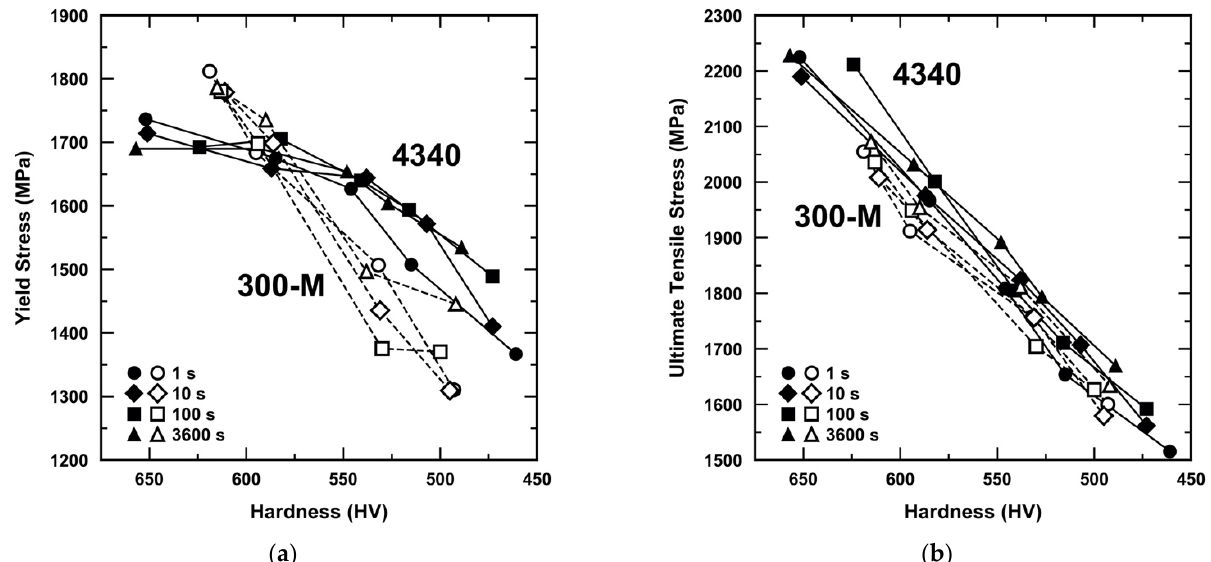
Figure 1. Comparison of (a) yield strength (0.2 pct offset) and (b) ultimate tensile strength of 4340 (closed) and 300-M (open) as a function of decreasing hardness.